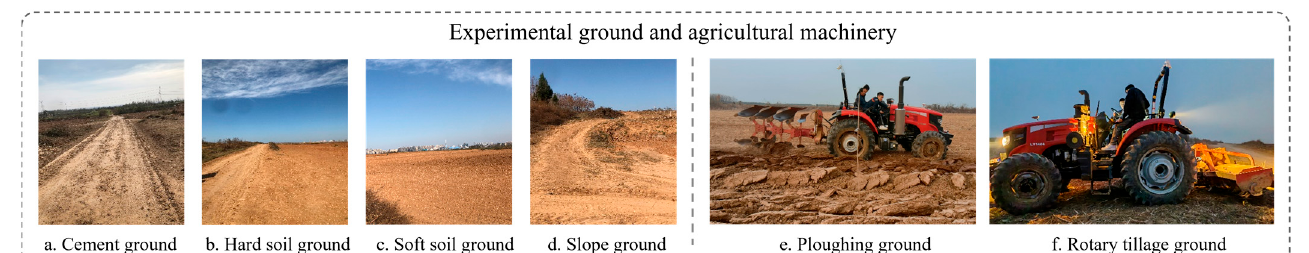
Figure 4. Farm implements and the experimental ground sections.